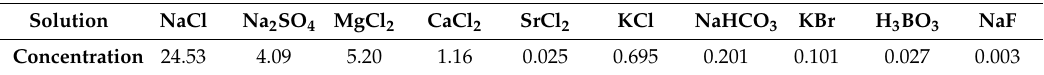
Table 1. Chemical composition of standard